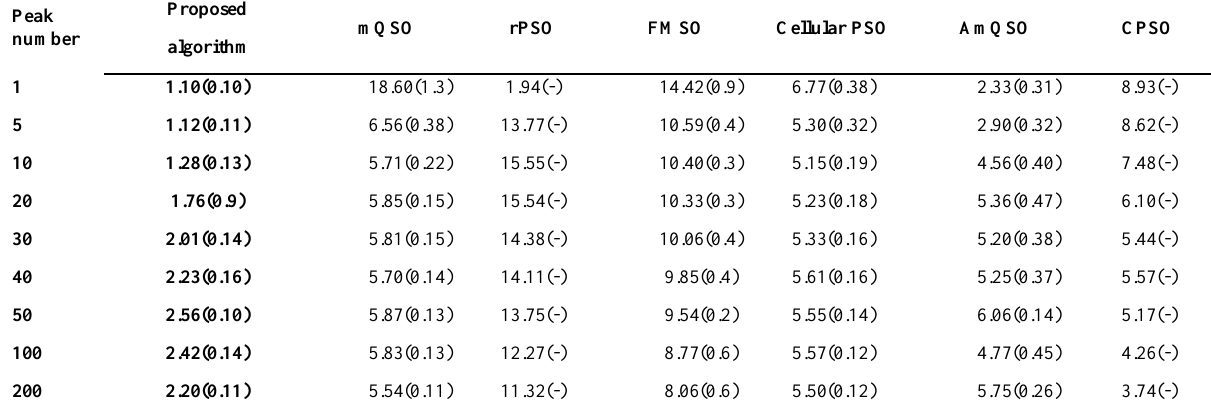
Table 4. Average offline errors for different algorithms on MPB problem with different numbers of peaks and frequency 1000.